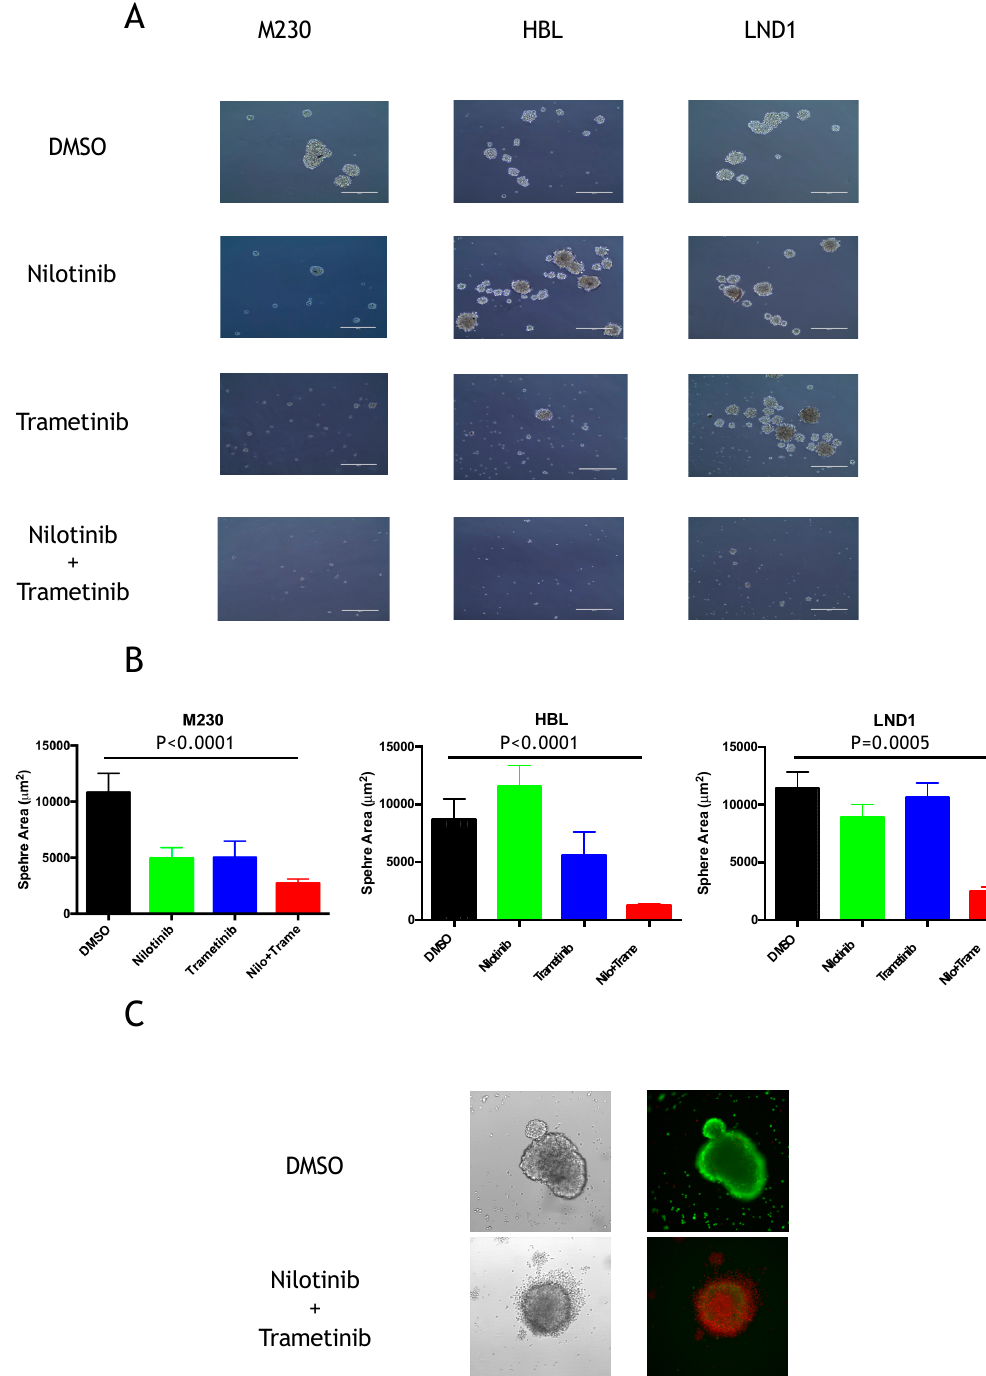
Figure 5. Effects of KIT and MAPK inhibitors on 3D proliferation. ( A ) Cells were dispensed in low-adherent plates in neural crest cell medium in the presence of DMSO, 1 µ M nilotinib, 0.2 µ M Trametinib or the combination of both and pictures were taken after 7 days (scale bar represents 400 µ m). ( B ) Graphs represent mean of the sphere areas of around 30 spheres +/ − SEM (similar results were obtained in two independent experiments). Variables were compared with the Mann–Whitney test. ( C ) HBL spheres formed after 7 days cells were treated with DMSO or the combination of 1 µ M nilotinib and 0.2 µ M Trametinib and after 48 h labelled for 1 h with the cell viability kit wherein living cells stain green and dead cells stain red. Magnification 20 × . Representative of three independent